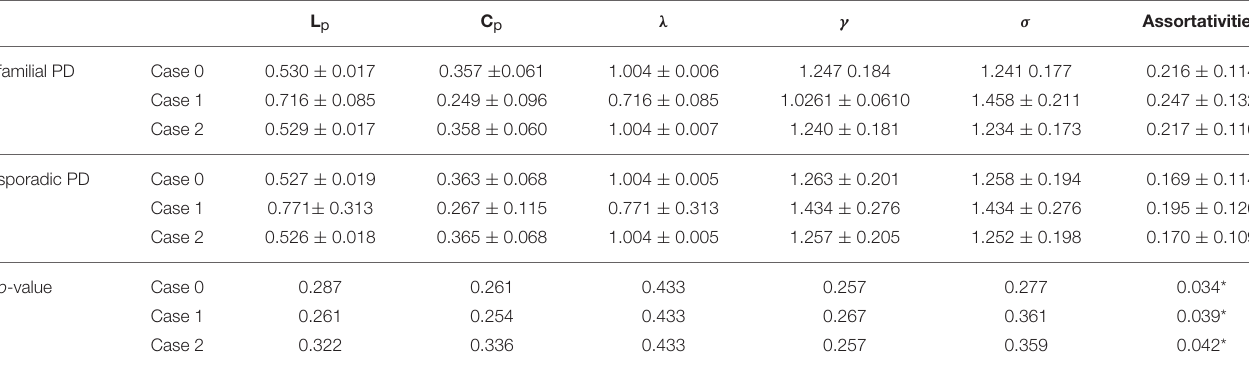
TABLE 2 | Comparisons of the global network metrics among the sporadic PD and familial PD on wavelet scale four. L p C p λ γ σ Assortativities familial